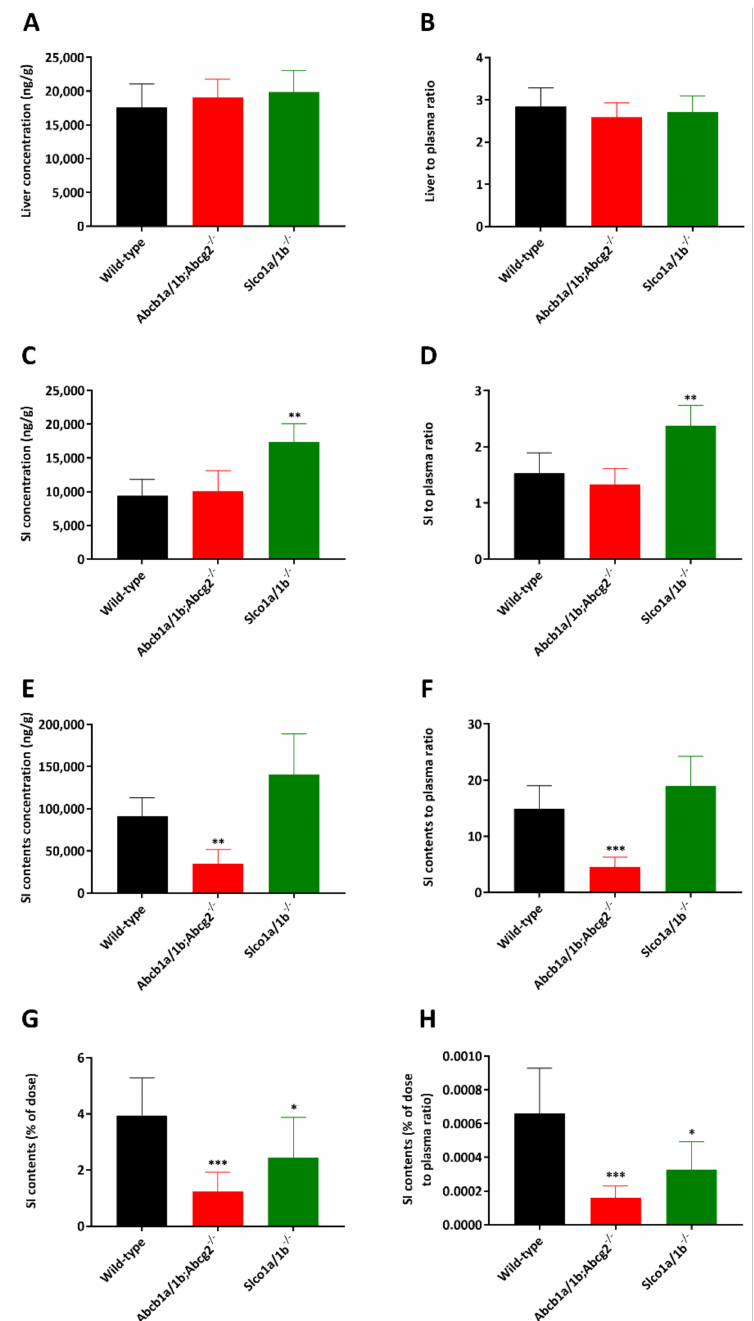
Figure 3. Liver, small intestine and small intestine contents concentrations ( A , C , E ), liver, small intestine- and small intestine contents-to-plasma ratios ( B , D , F ), small intestine contents as percentage of dose ( G ) and small intestine contents percentage of dose-to-plasma ratio ( H ) of selpercatinib in male wild-type, Abcb1a/1b; Abcg2 -/- and Slco1a/1b -/- mice over 4 h after oral administration of 10 mg/kg selpercatinib. SI: small intestine. Data are given as mean ± S.D. (n = 6–7). *, p < 0.05; **, p < 0.01; ***, p < 0.001 compared to wild-type mice. Statistical analysis was applied after log-transformation of linear